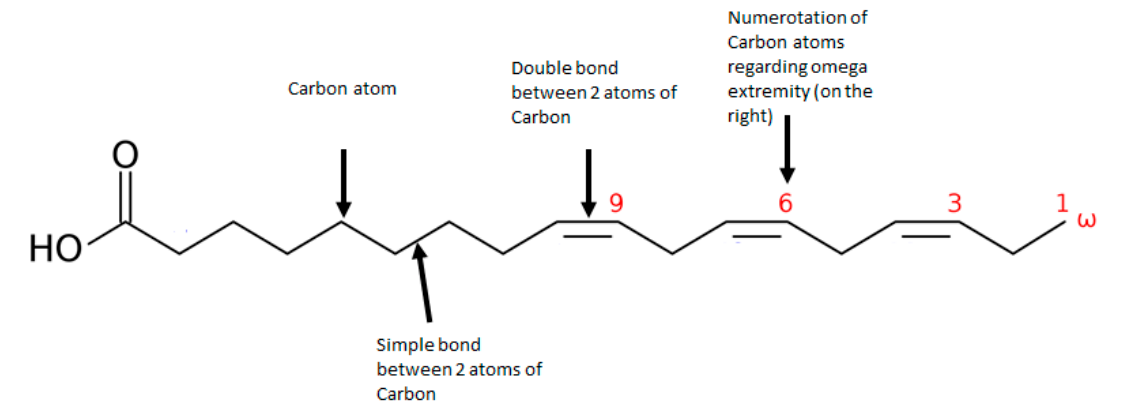
Figure 1. Representation of an omega 3 polyunsaturated fatty acid: α -linoleic acid